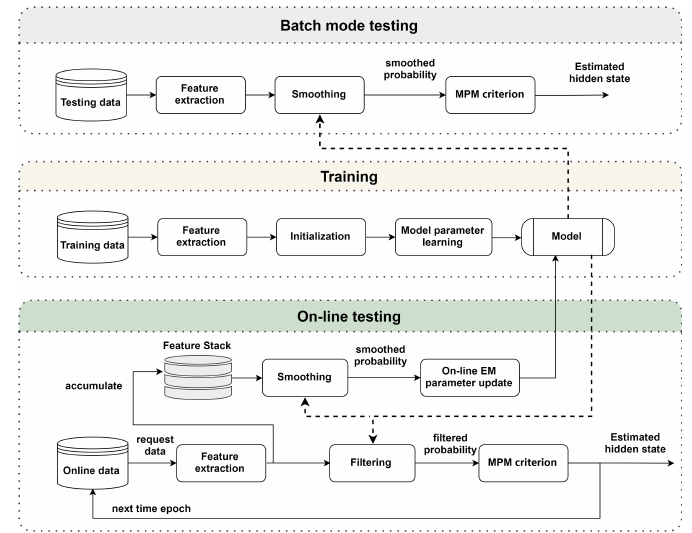
Figure 3. Diagram of the training stage, and the testing stage for both batch mode and on-line